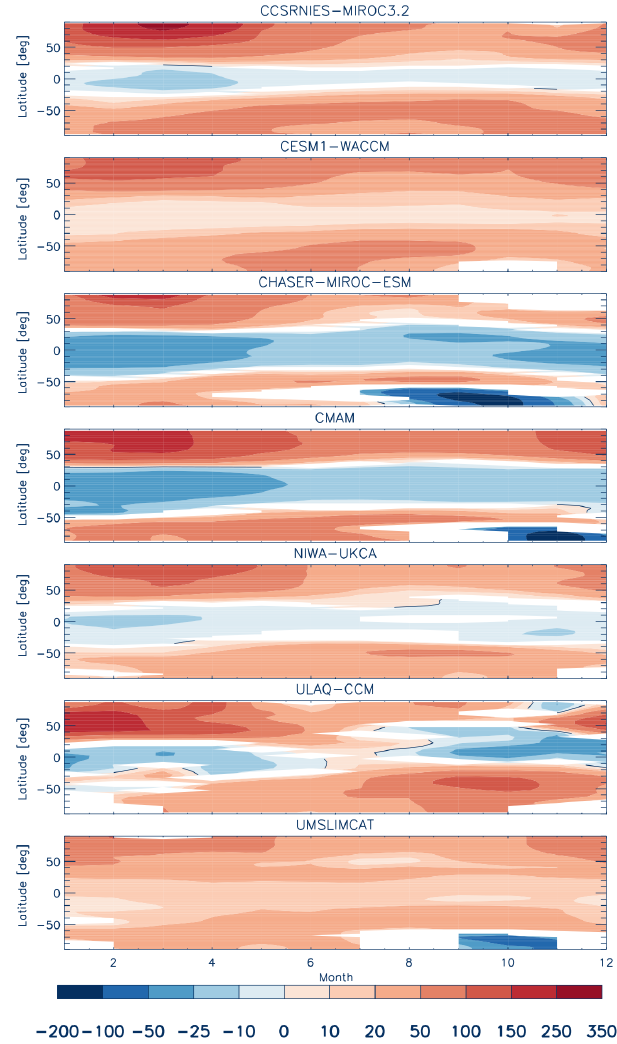
Figure 11. Same as Fig. 2 but for CO 2 eq . , in units of 10 − 3 DUppmv − 1 (CO 2 eq . ), derived from the REF-C2, SEN-C2- fGHG, SEN-C2-fCH4, and SEN-C2-fN2O simulations.